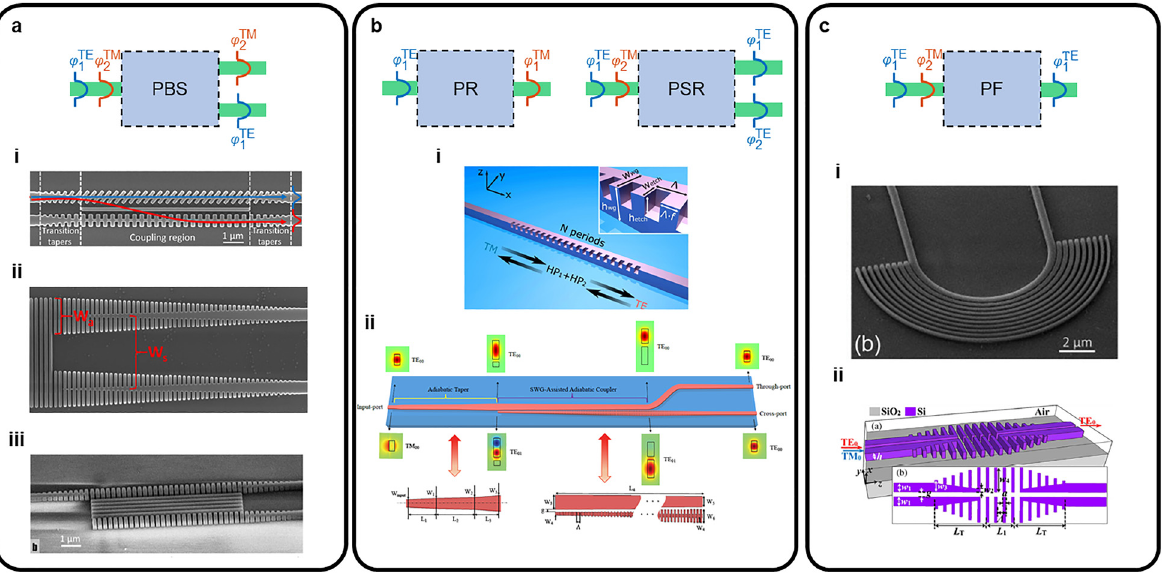
Figure 13: Configurations of polarization controlling